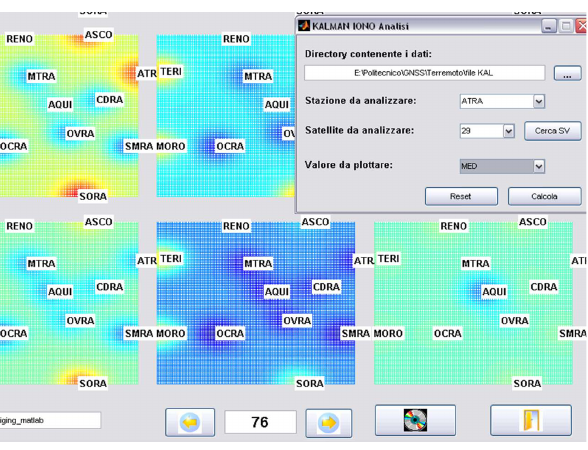
Fig. 7. Screenshots of the developed